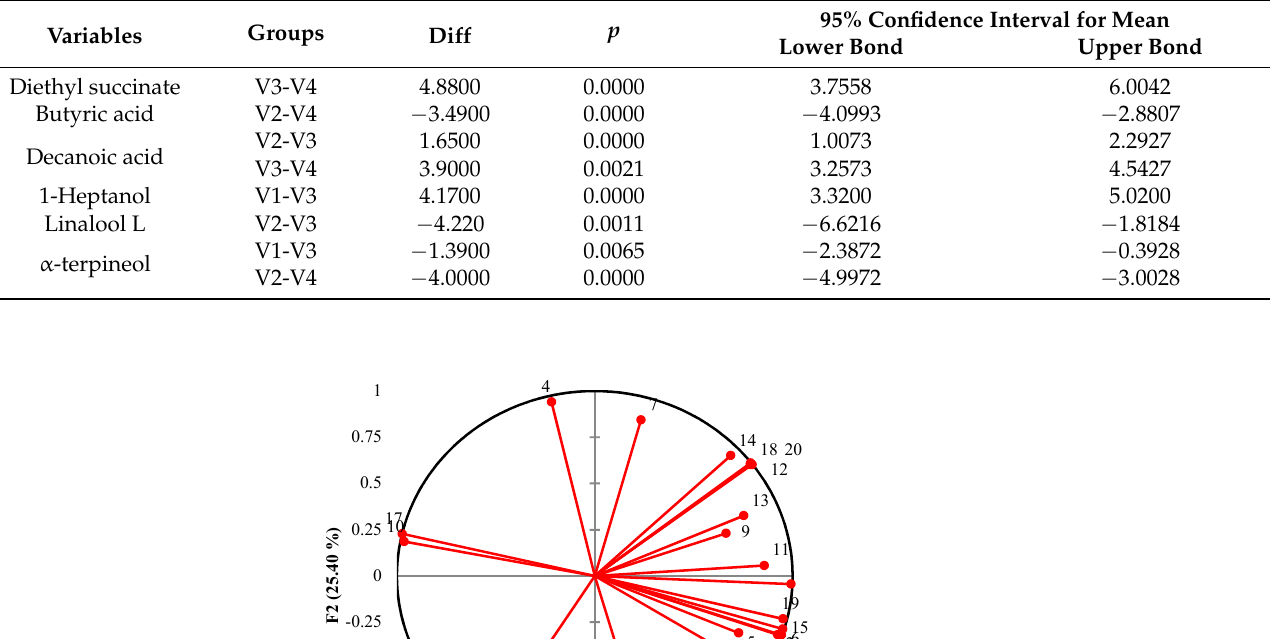
Table 3. Significant results of Tukey’s HSD post-hoc test.